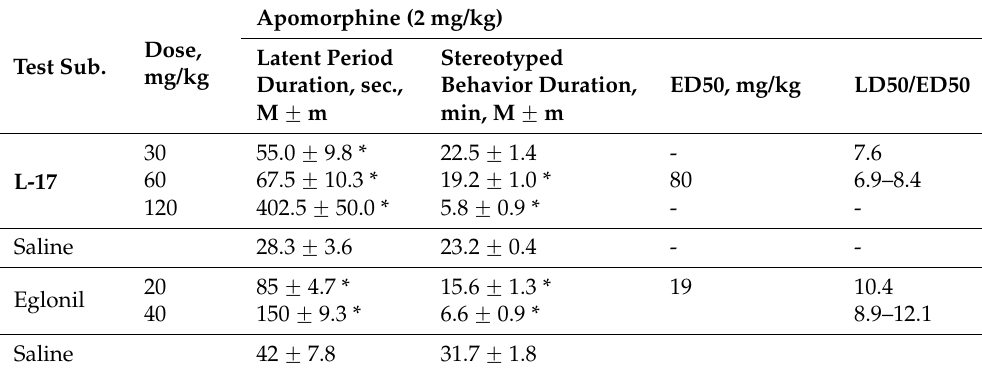
Table 2. Changes in apomorphine-induced stereotypy following administration of compound L-17 .